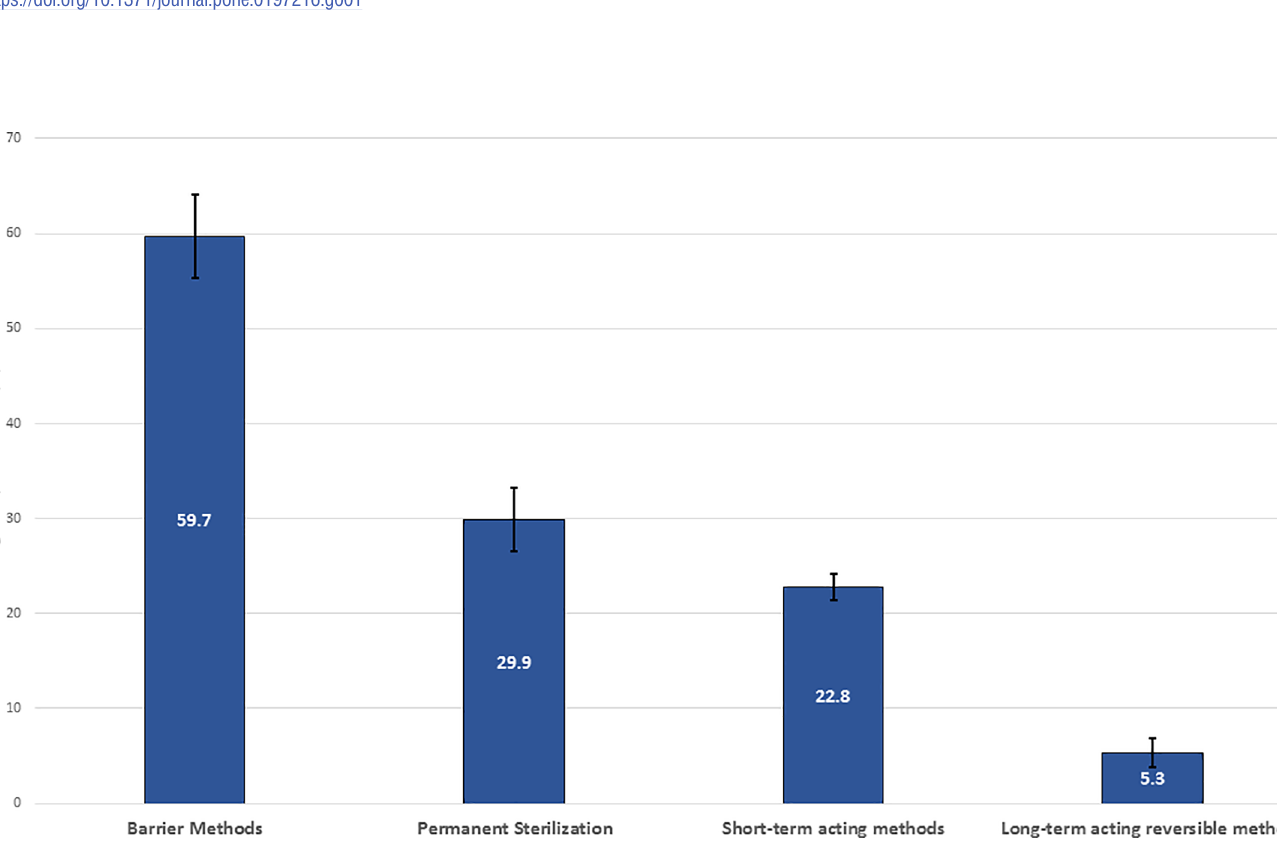
PLOS ONE | https://doi.org/10.1371/journal.pone.0197216 May 17,